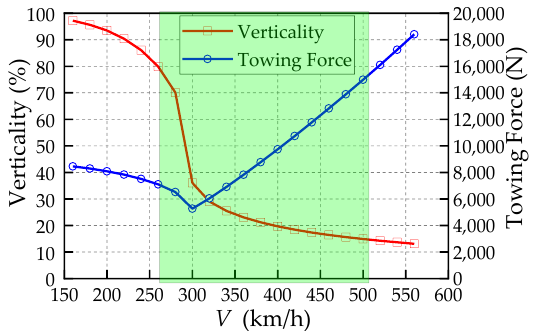
Figure 19. Verticality and towing force vs. indicated rotational airspeed.